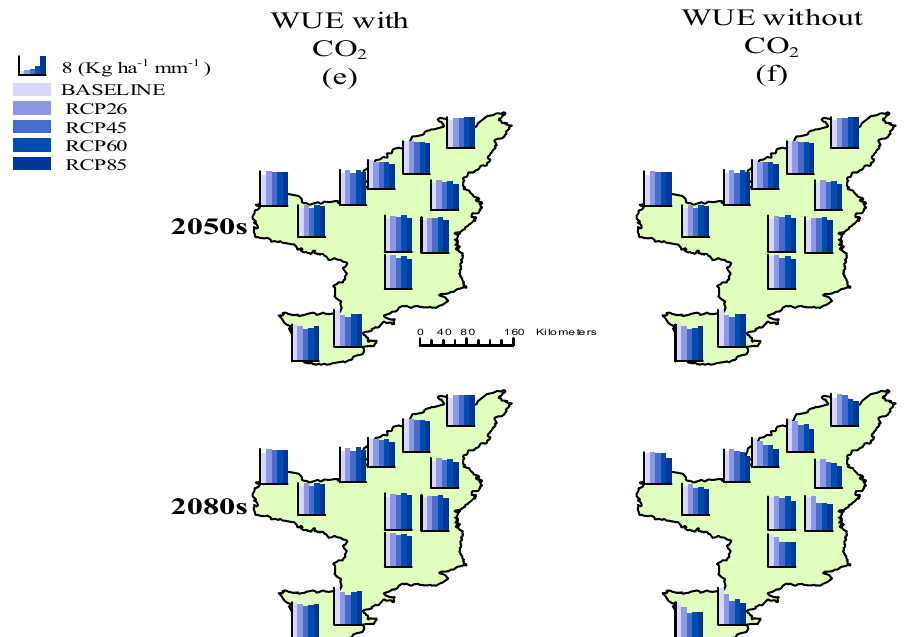
Figure 4. Spatial and temporal evolutions of ( a , b ) the yields with and without CO 2 (t ha − 1 ), ( c , d ) evapotranspiration (mm) with and without CO 2 , and the water use e ffi ciency (Kg ha − 1 mm − 1 ) ( e , f ) with and without CO 2 during the 2050s and